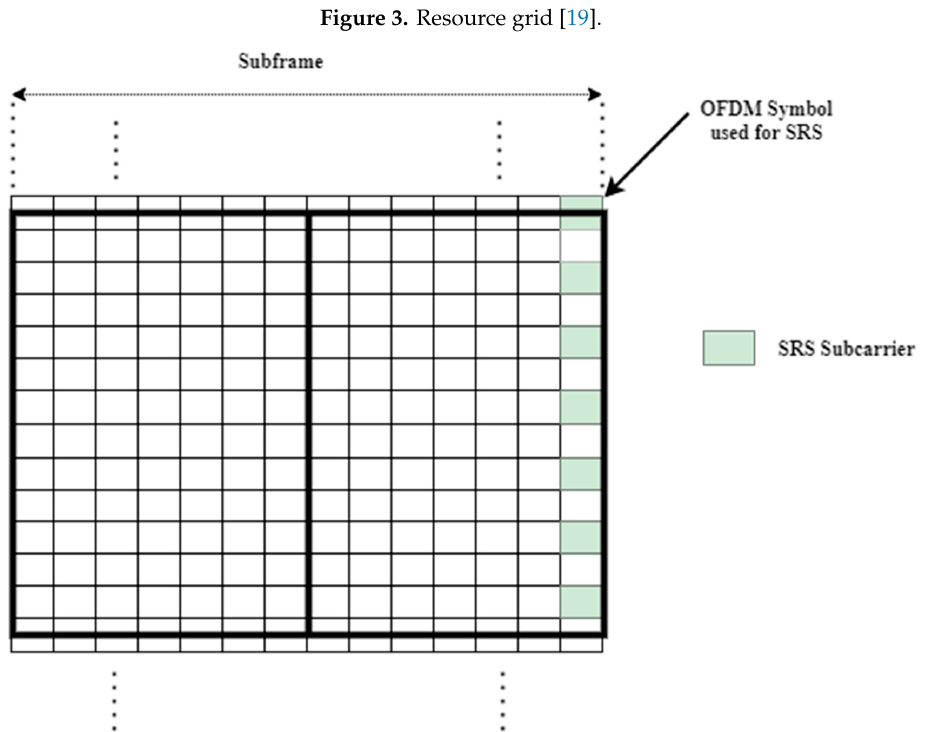
Electronics 2020 , 9 , x FOR PEER REVIEW